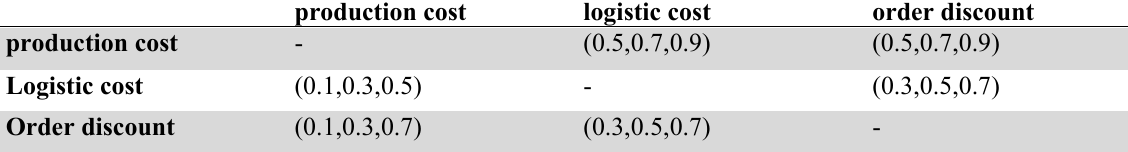
Paired-wise comparison of cost sub-criteria